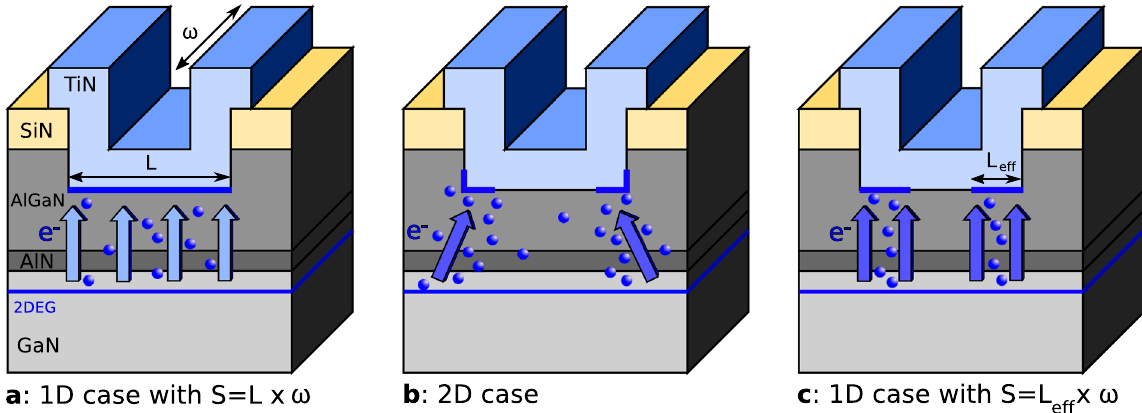
Figure 4. Electron flow under the anode contact. ( a ) 1D standard case, the current is assumed constant over the entire anode length. ( b ) 2D case, the current varies over the anode length with the majority of the current emitted at the periphery. ( c ) 1D intermediate case, an effective length is introduced at the edges of the anode and over which the current is assumed constant.